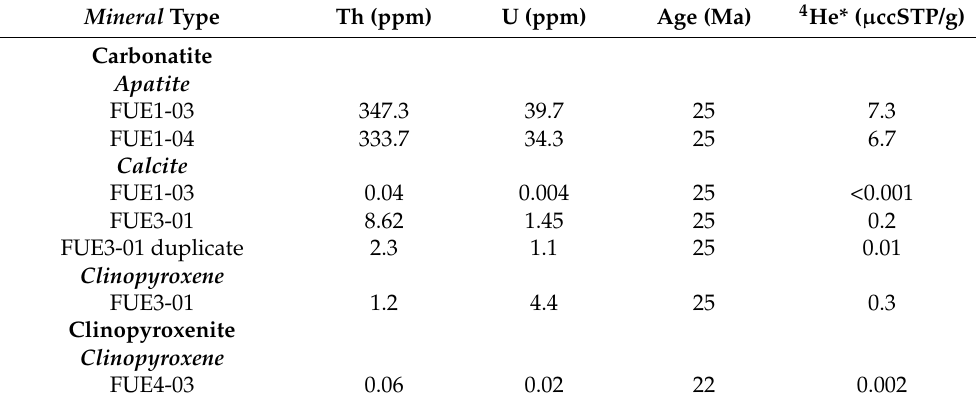
Table 4. Th and U concentrations and related 4 He* production in mineral separates from Fuerteven- tura carbonatites and